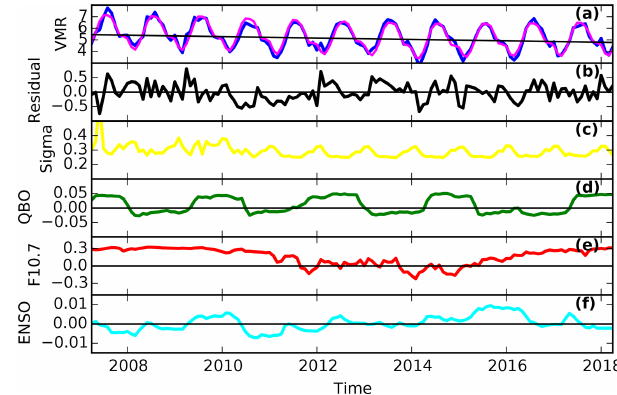
Figure 5. Panel (a) shows the trend fit at 0 . 04hPa (70km), with the MIAWARA monthly mean H 2 O data (blue line), the calculated model fit (magenta line) and the related linear trend (black line). Panel (b) shows the residual, and in the following panels (c) , (d) , (e) and (f) the evolution of the σ uncertainty (yellow line), the fitted signals of the QBO (green line), F 10 . 7 (red line) and ENSO (cyan line) proxies at 0 . 04hPa are